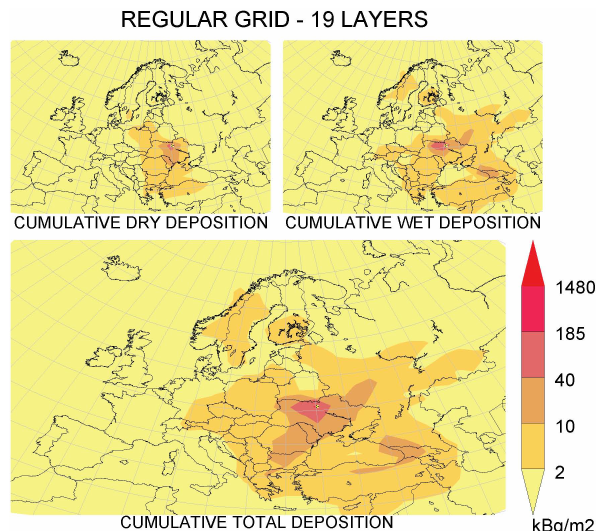
Fig. 12. Cumulative dry, wet and total deposition of 137 Cs (kBqm − 2 ) from the day of the accident (26 April 1986) until the end of 1986. Results of the simulation using the regular grid of the model for 19 vertical layers and accounting for the altitude of the emissions with respect to Table 1